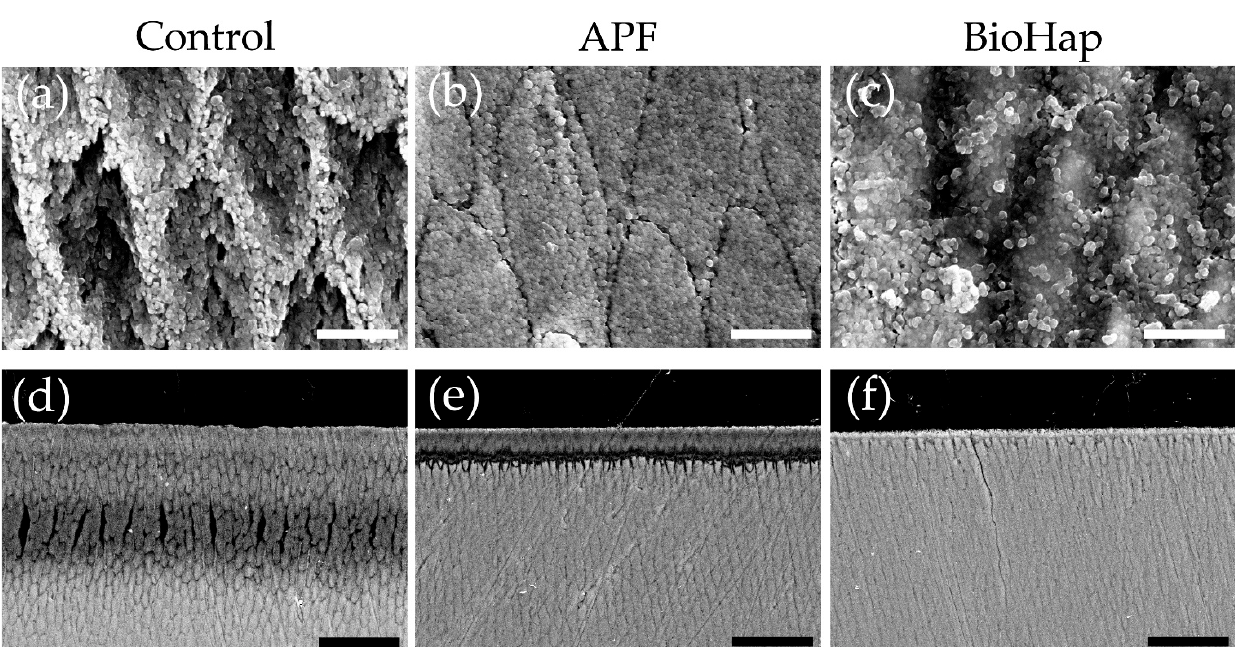
Figure 4. SEM images of enamel surface and cross-sections after acid challenge. Surface SEM images of the ( a ) control, ( b ) APF, and ( c ) BioHap groups. Scale bar is 2.5 µm. All images were recorded at 10,000× magnification carbon deposition samples. Cross-sectional SEM images of the ( d ) control, ( e ) APF, and ( f ) BioHap groups. Scale bar is 25 µm. All images were recorded at 1000× magnification carbon deposition samples.